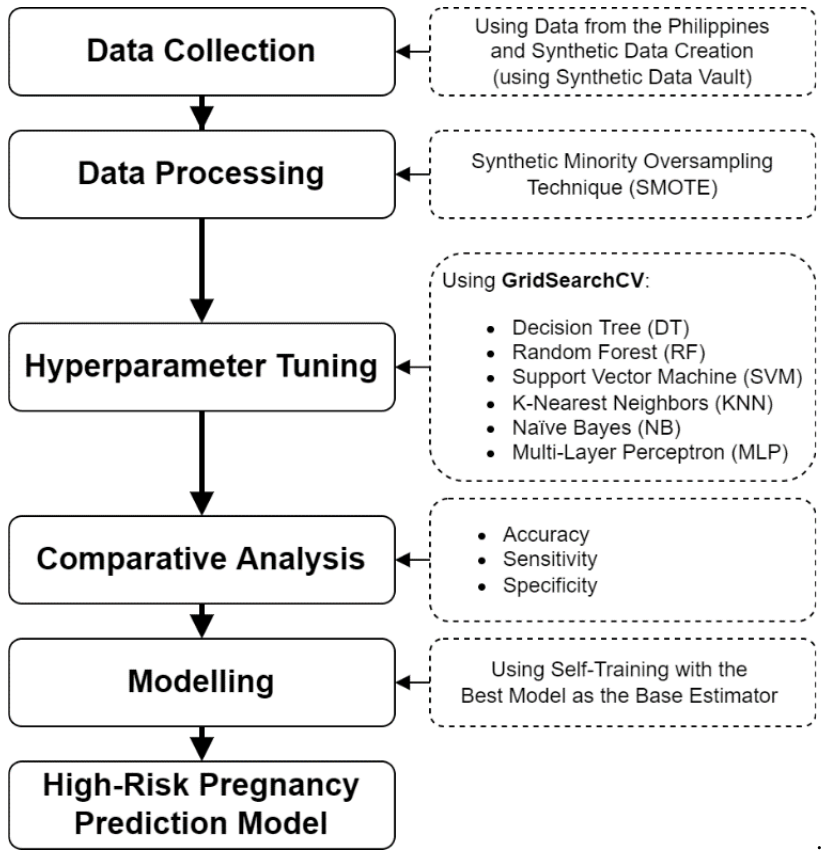
Figure 1. Block diagram of the machine learning process. The process involved five phases: data collection, data processing,